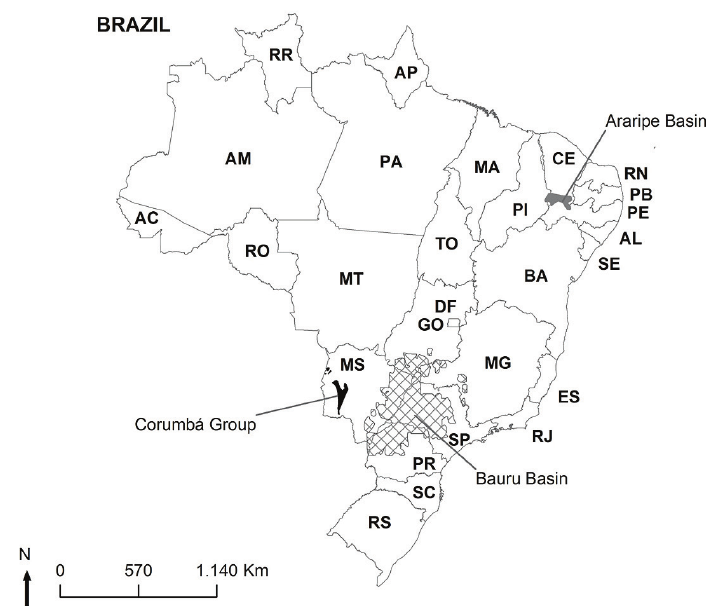
Figure 1. Brazil map with the locations of geological settings where fossils used in this work